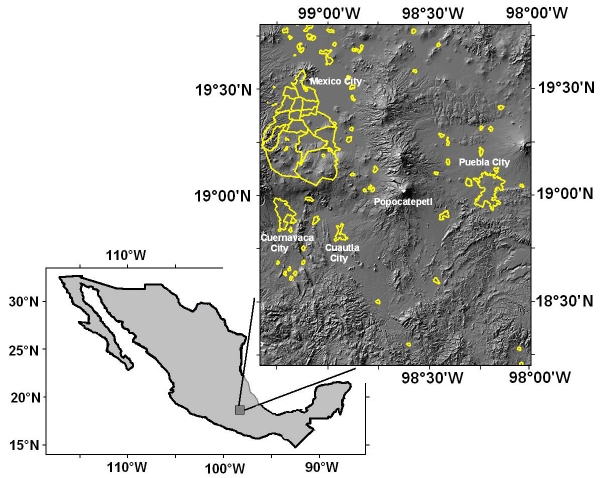
Fig. 1. Locations of Popocat´epetl volcano and major cities and towns. About 20 million people could be potentially affected by tephra fallout produced by a major